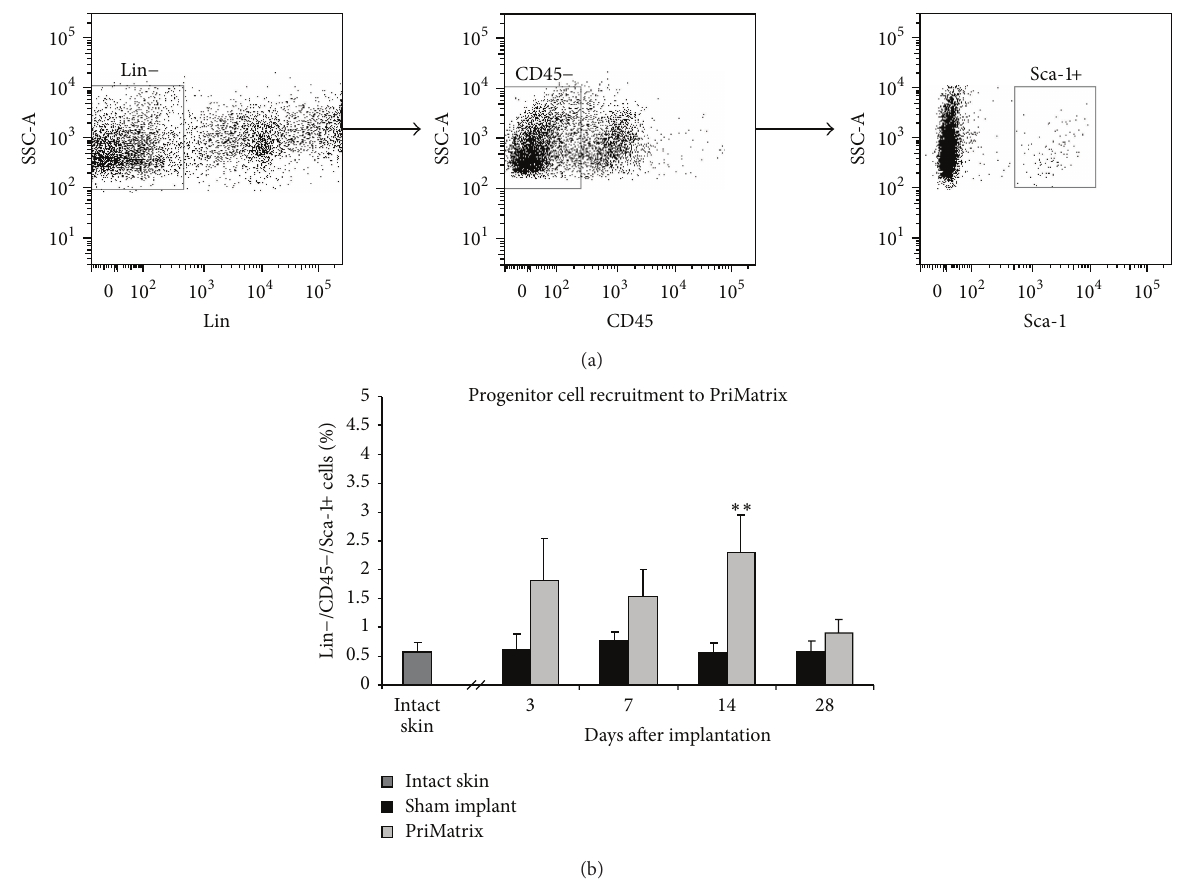
Figure 6: Flow cytometric analysis of the progenitor cell response to PriMatrix implants. (a) Gating scheme for the progenitor cell analysis. (b) Quantification of the progenitor cell response, demonstrating a significant increase in cell recruitment on day 14 compared to controls. ∗∗ Significant compared to intact skin and sham implant controls. Lin: lineage